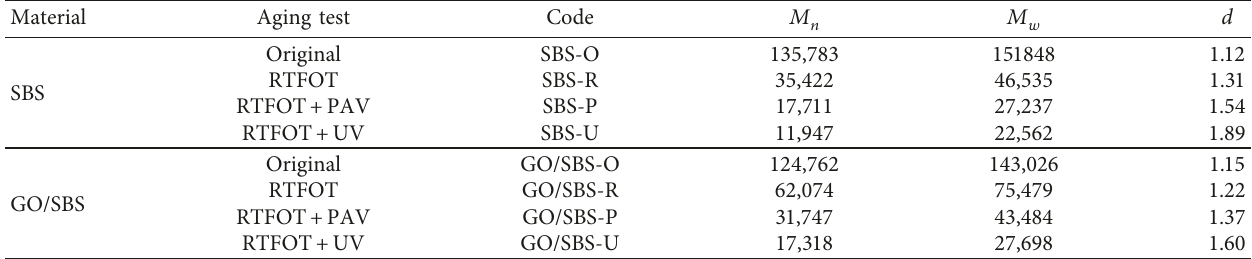
Table 4: Molecular weight calculation results for the GO/SBS